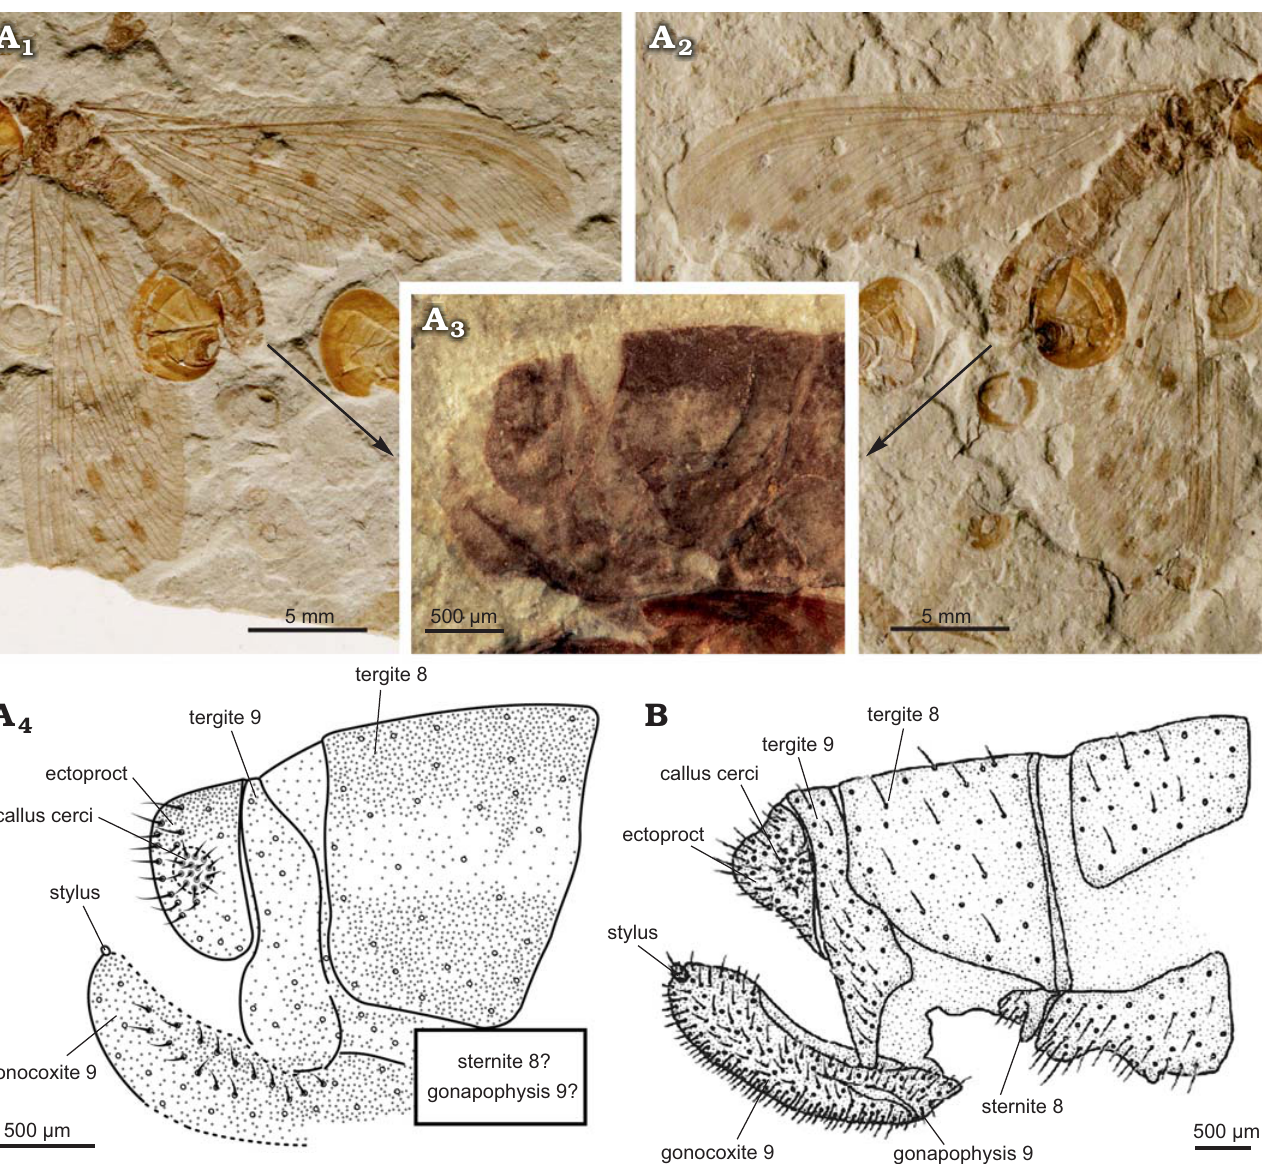
Fig. 3. Female lance lacewing Vetosmylus maculosus gen. et sp. nov. (paratype, CNU − NEU − NN2019003P/C) from Aalenian–Bajocian boundary (Middle Jurassic) of Jiulongshan Formation of Daohugou, China ( A ) and extant Parosmylus tibetanus Yang, 1988 ( B ). A . Photographs of part part (A 1 ) and coun- terpart (A 2 ); terminalia in lateral view, a combination of photos of part and counterpart under dry condition (A 3 ) and line drawing (A 4 ), sternite 8 and gonapophysis 9 cannot be clearly observed. B . Line drawing of terminalia in lateral